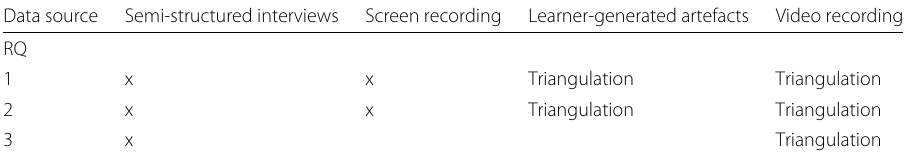
Table 1 Data sources used to answer the RQs Data